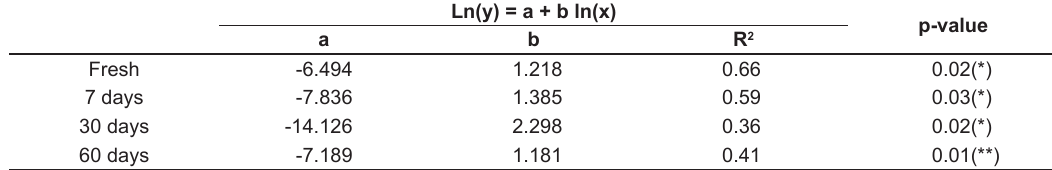
Figure 2. Mean and standard error of dry weight (a.) and body length (b.) by treatments. Table 2. Regression coefficients for dry weight-length relationships in the different treatments (fixation time).